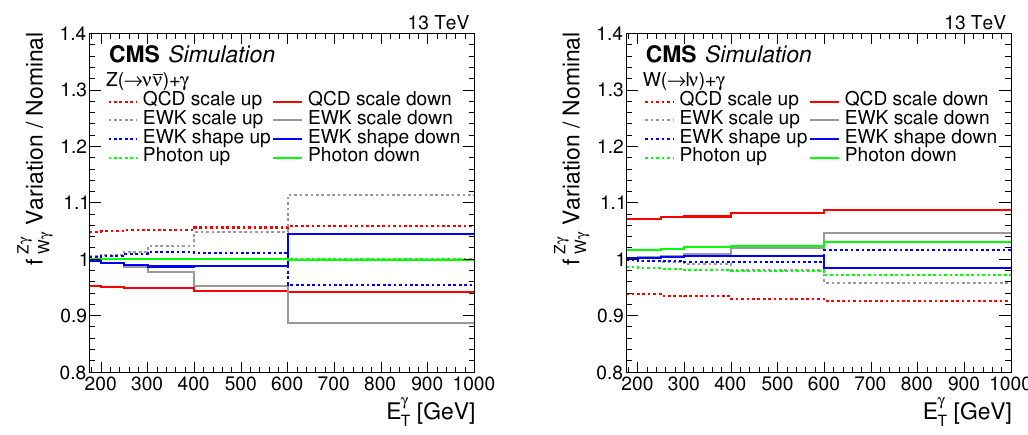
Figure 13 . Systematic uncertainty in the transfer factors for Z( ! (cid:23)(cid:23) )+ (cid:13) (left) and W( ! ‘(cid:23) )+ (cid:13) (right). The last bin includes all events with E (cid:13)